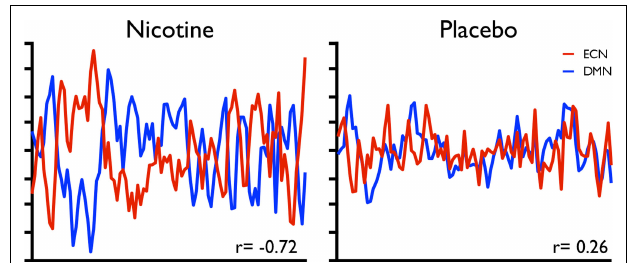
FIGURE 5 | Variability in the strength of inverse coupling between two RSNs (the DMN and a putative executive control network sharing spatial similarity with a combination of regions overlapping with RSN maps from Figures 1F,G,H) associated with individual differences in therapeutic behavioural changes following nicotine pharmacotherapy, compared to placebo. These data are taken from a single subject within a group of smokers tested using resting-state FMRI with repeat measures in a double-blind, placebo- controlled, crossover design (reproduced from Cole et al., under